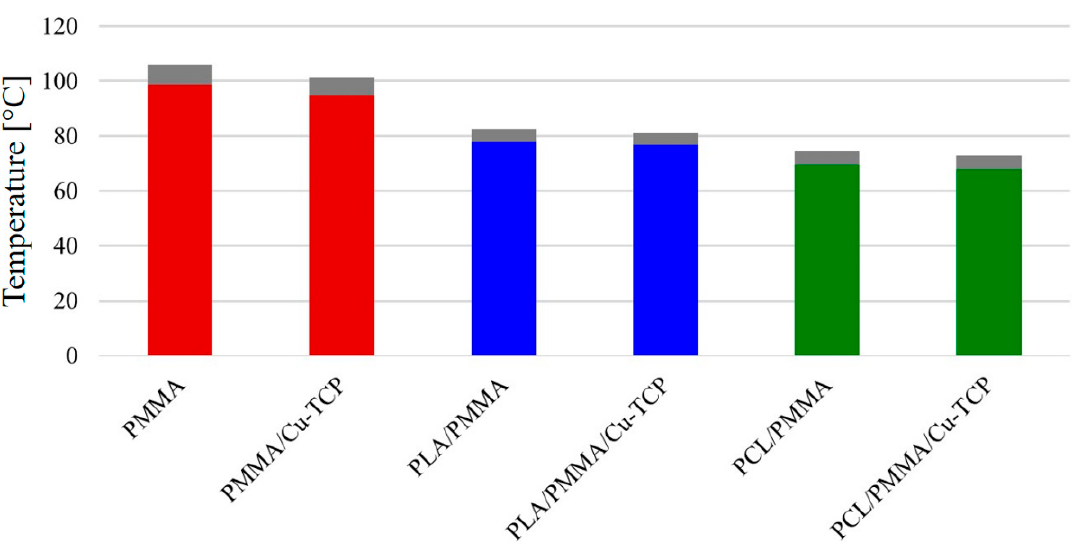
Figure 7. Temperature peaks measured during setting in the case of plain bone cements (PMMA, PMMA/Cu-TCP) and hybrid structures consisting of 3D polylactic acid (PLA) or poly( ε -caprolactone) (PCL) networks infiltrated with cement. Statistical analysis was performed by analysis of variance (ANOVA). Statistical significance was set at p < 0.05.